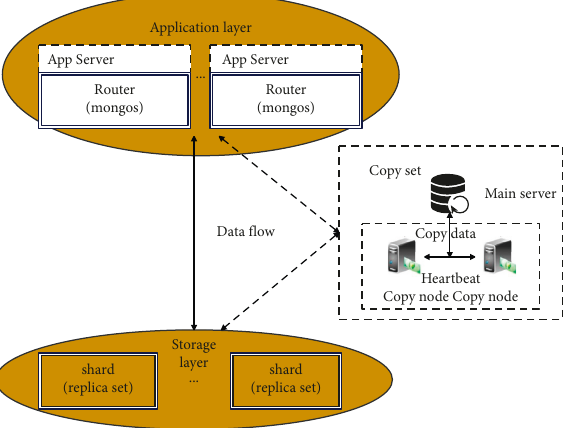
Figure 7: Cluster architecture